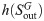
Distributions of the h(SoutG) and h(SinG) values for all three graph classes.